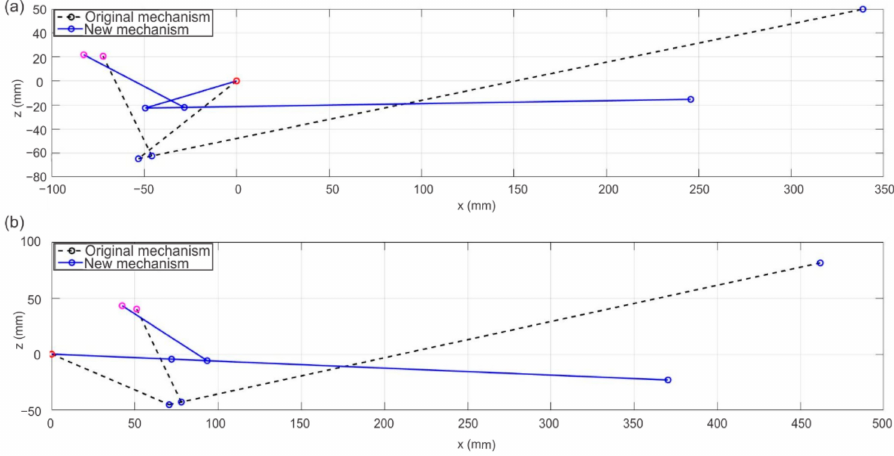
Figure 23. Comparison between the two mechanisms in their extreme positions: ( a ) flexion and ( b ) extension.